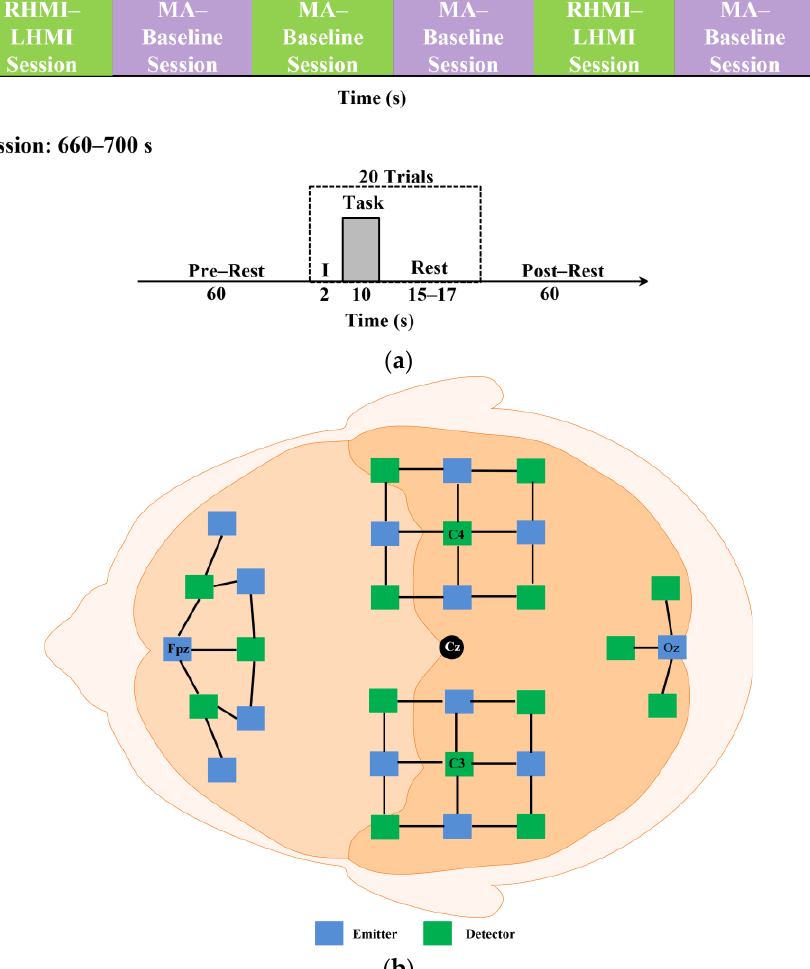
Figure 2. ( a ) Experimental paradigm; ( b ) fNIRS optodes